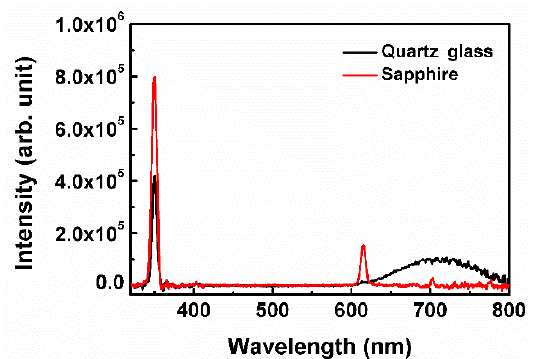
Figure 6. Photoluminescence (PL) spectra of the as-received ZnO thin films grown on the quartz glass and sapphire substrates. and sapphire